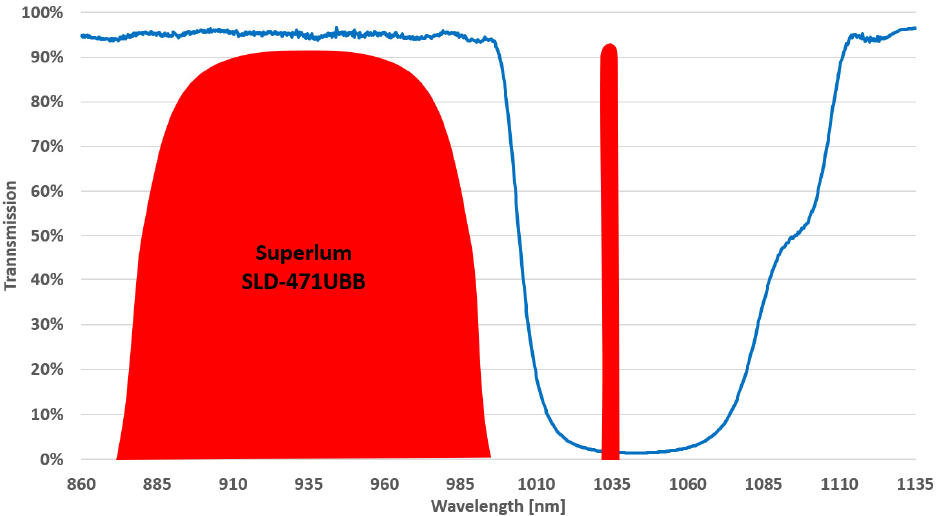
Figure 1. Transmission curve of the beam splitter with drawn-in spectra of the process laser and the selected light source.